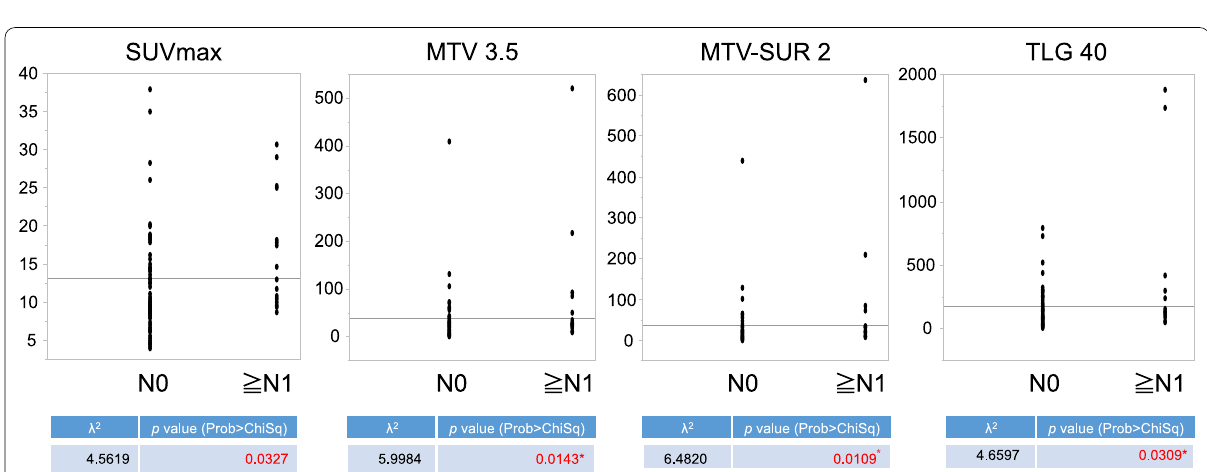
Fig. 5 Relationship between metabolic parameters and lymph node metastasis. SUVmax: maximal standardized uptake value, MTV 3.5: SUVmax of 3.5 for metabolic tumor volume, MTV-TLR2: tumor-to-liver uptake ratio of 2 for metabolic tumor volume, TLG 40%: 40% of tumor SUVmax for total lesion glycolysis. The increase in glucose metabolic parameters with the progression of the N stage revealed that PET parameters (SUVmax, MTV, and TLG), especially TLR of 2 for MTV (MTV-TLR2), were significantly different between pathological N0 and other N